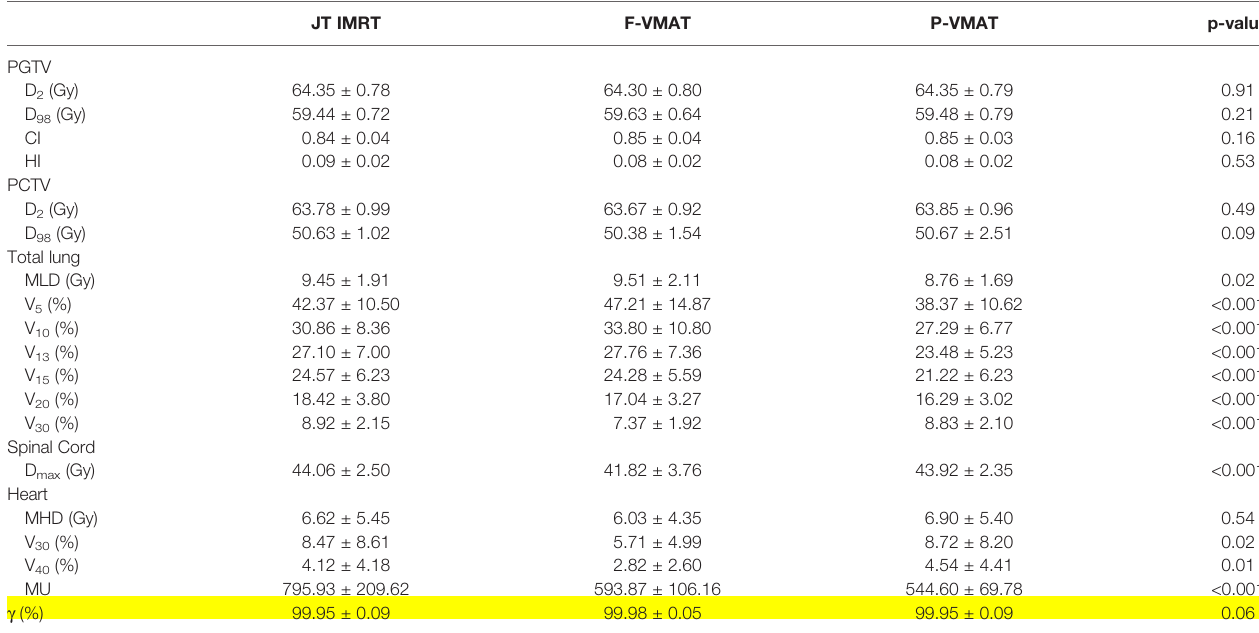
Highlighted text means g passing